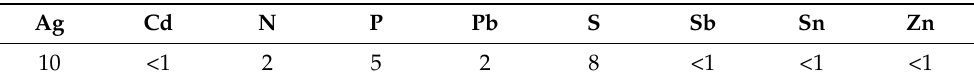
Figure 3. Particle size distribution of feedstock unalloyed copper powder used across the builds ( A ), and SEM image of the powder prior to the first build ( B ); scale bar shows 100 µm. Table 4. ICP-MS analysis of feedstock unalloyed copper powder prior to the first build. Values are reported in wt.